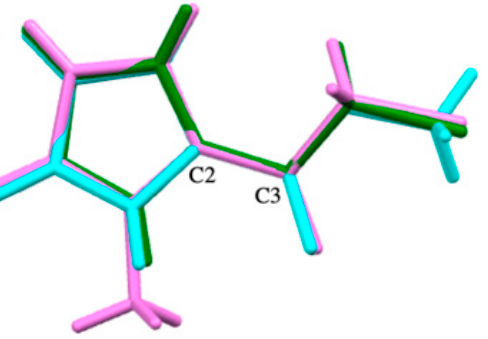
Figure 2. Structural overlay of molecular structures for all compounds in stick style (lavender color denotes I , green— II , blue— III ).